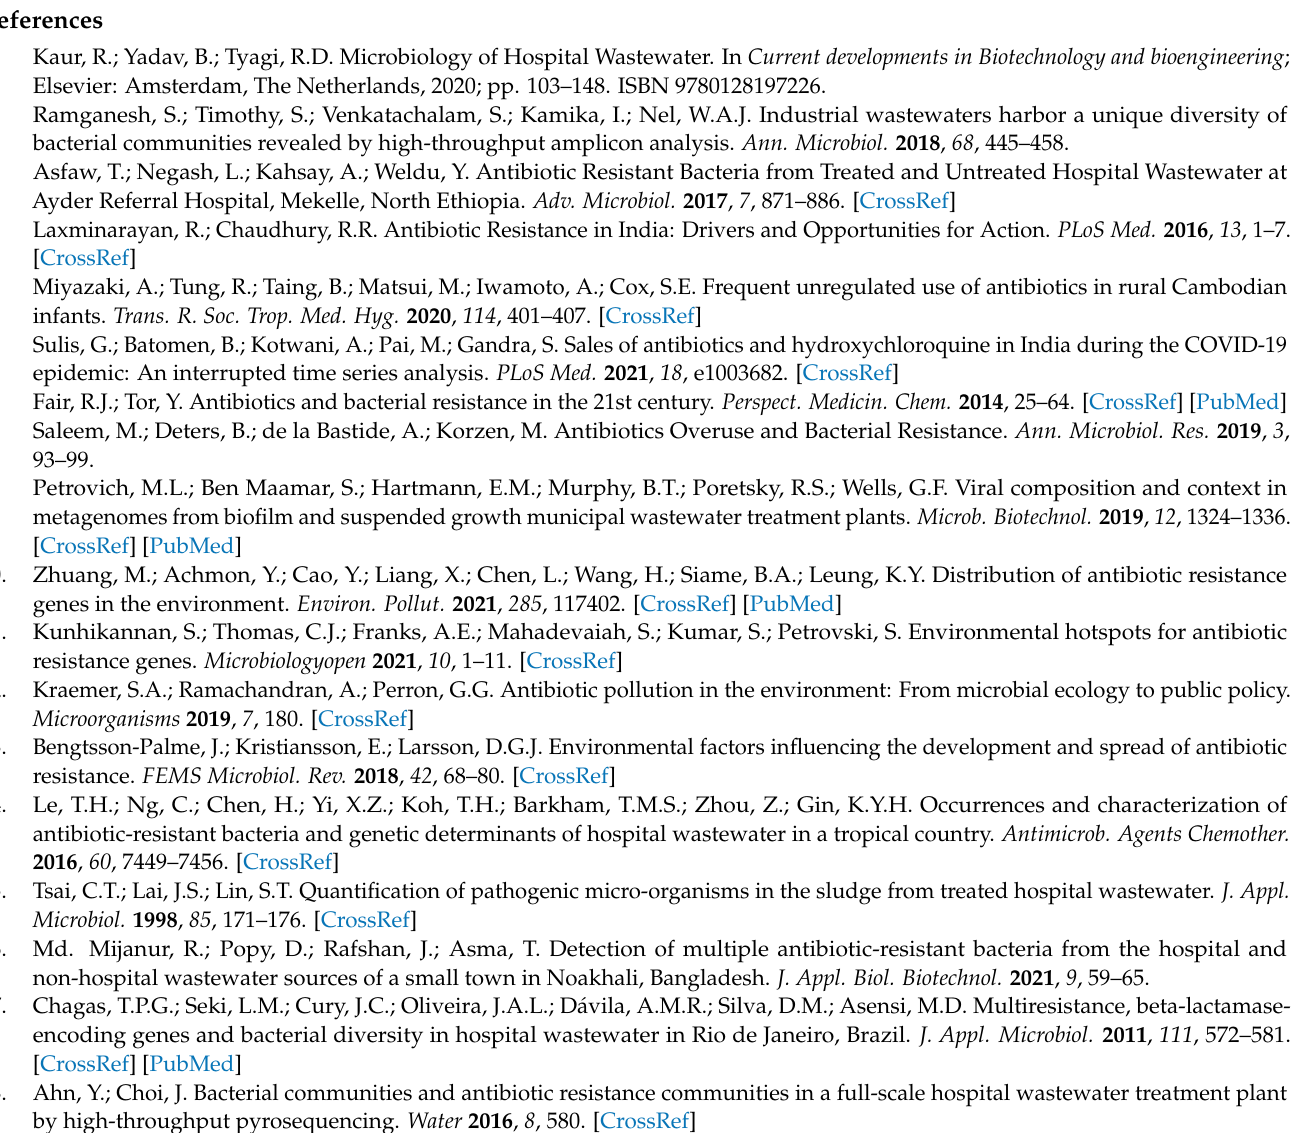
effluent samples. Table S1: Summary of occurrence and concentration of antibiotics in collected wastewater